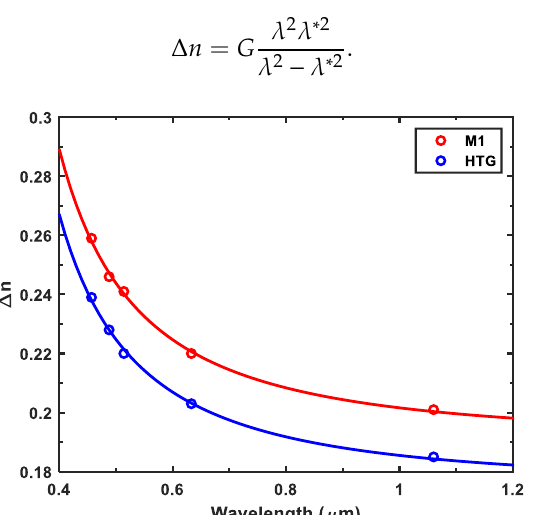
Figure 3. Wavelength-dependent ∆ n of M1 and HTG. Dots are measured data and solid lines are fitting curves with Equation (4). The fitting parameters are listed in Table 2.